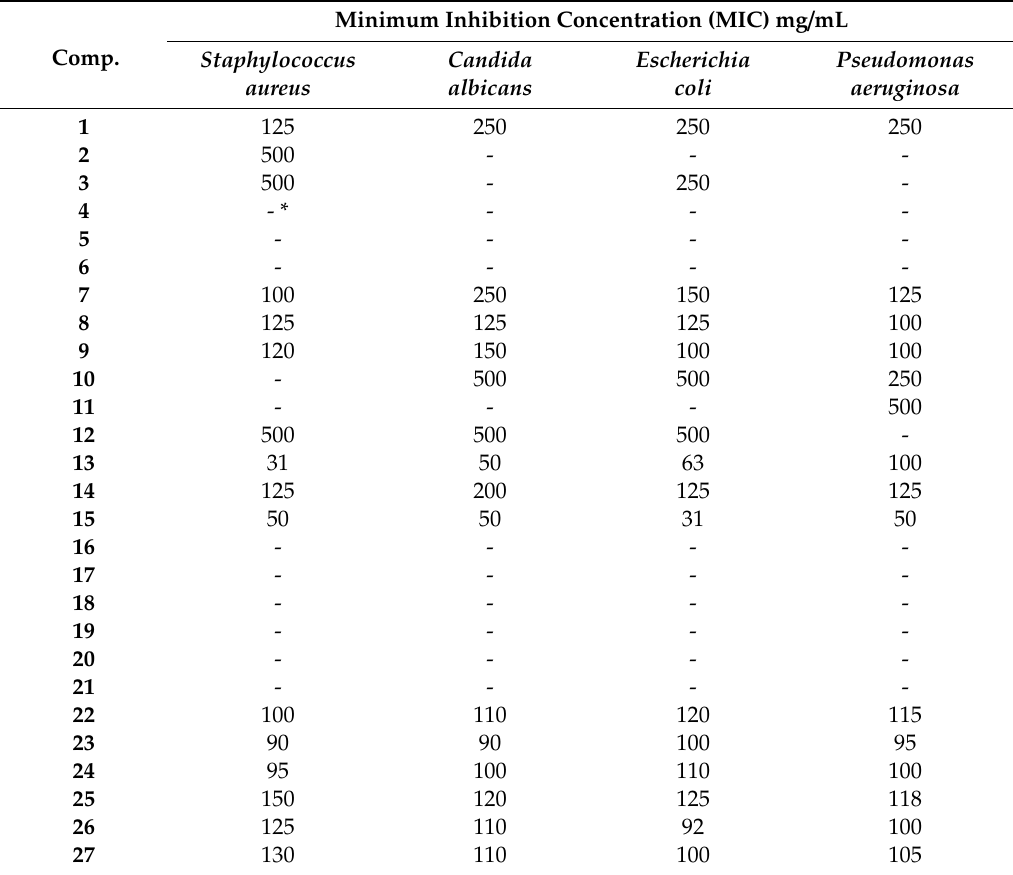
Table 3. Minimum inhibition concentration (MIC) mg / mL of synthetic compounds 1 – 27 .